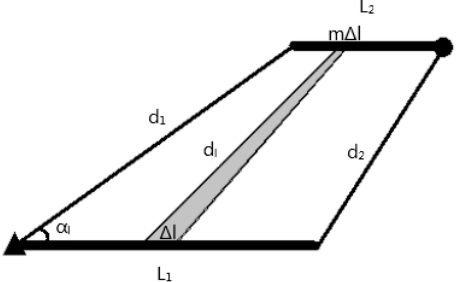
a quarter of the well network.